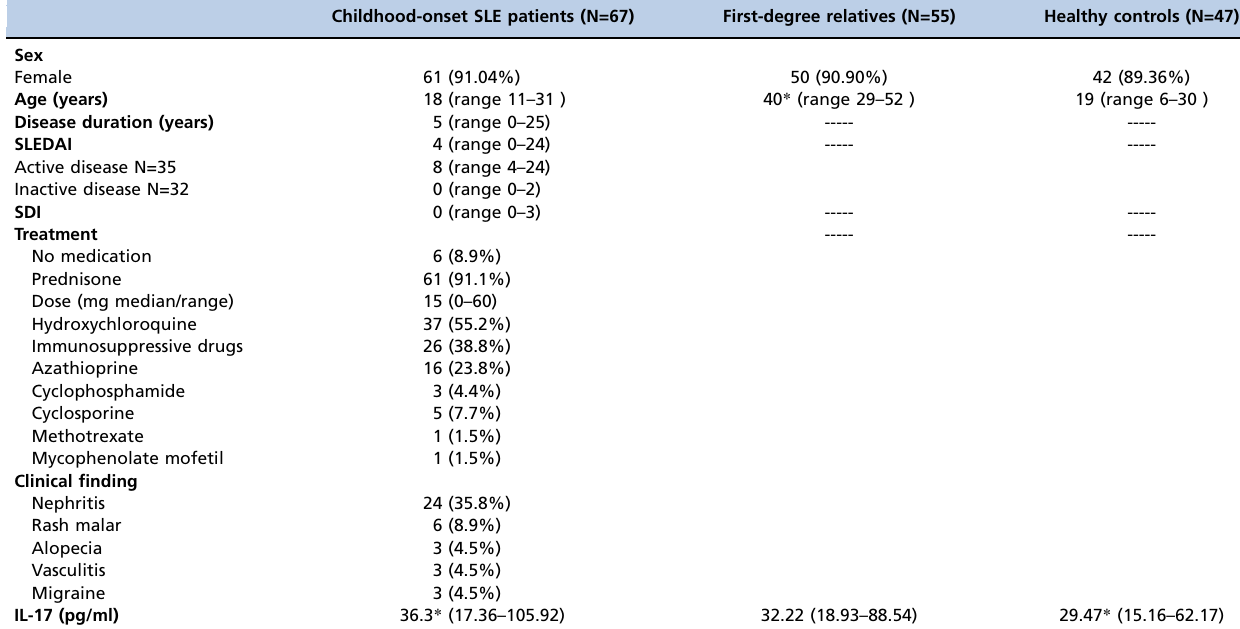
Table 1 - Demographic and clinical characteristics and IL-17 levels of the patients and controls included in the study.